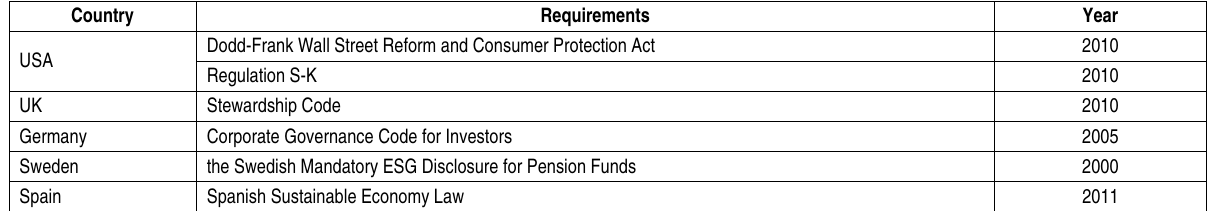
Table 4. Regulatory instruments for mandatory SR disclosure in financial